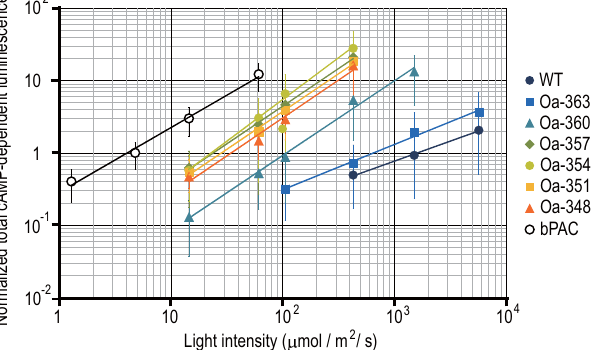
Figure 3. The nine amino acids at the C-terminal critically affect the photoactivity. Dose-response curves for the photoactivities of PACs. cAMP-dependent luminescence of each cell was measured, and the total cAMP- dependent luminescence of each cell was normalized to their expression. Data were collected from different cells, and normalized luminescence was plotted against irradiated intensities. PACs with shorter C-terminal regions produced larger amounts of cAMP. However, the deletion of more than nine amino acids did not further increase their activities. Bars indicate mean ± S.D. (n ≥ 25).